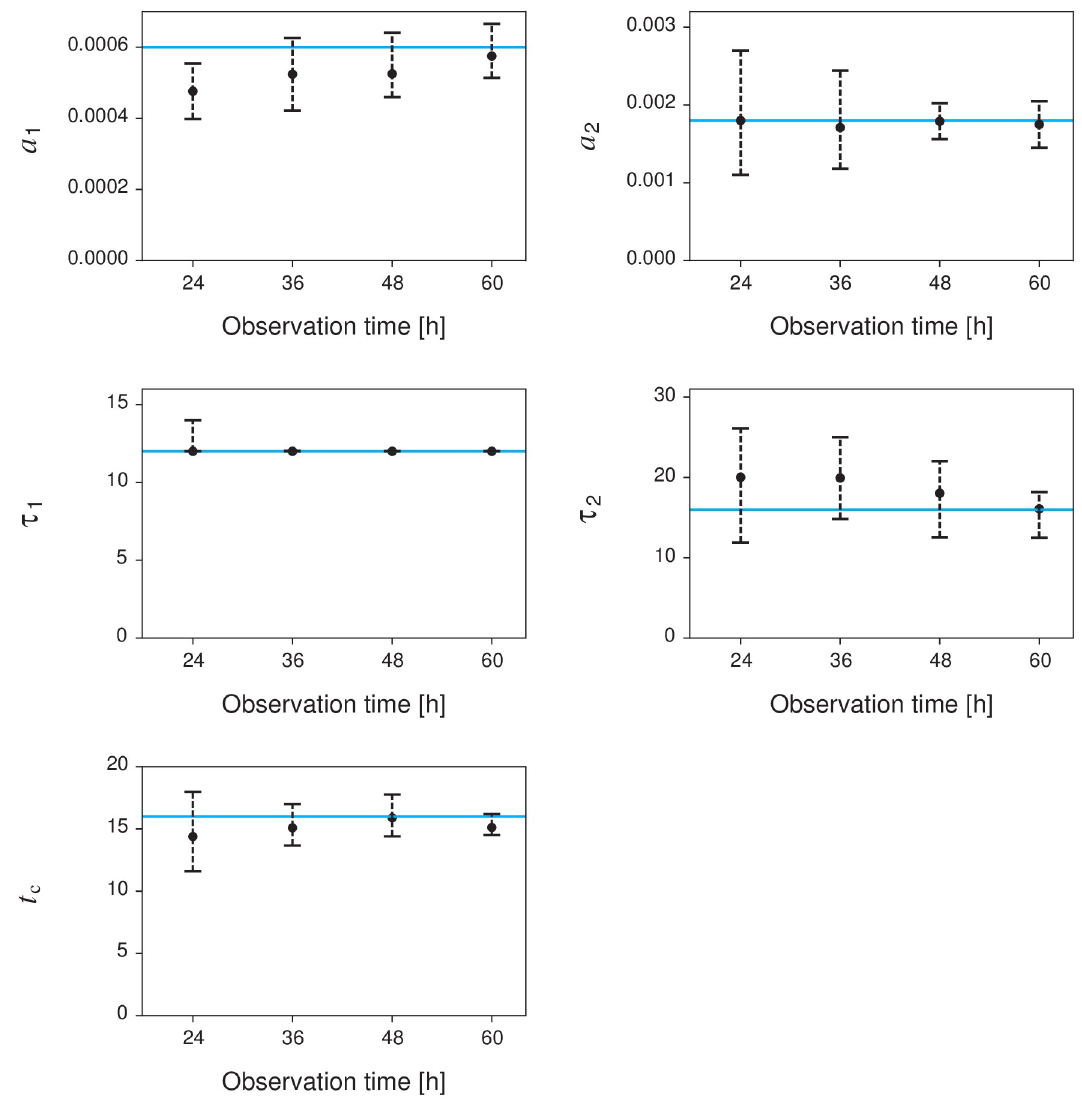
Fig 2. Dependence of the estimation accuracy of parameters { a 1 , τ 1 ; a 2 , τ 2 ; t represent the median and interquartile ranges of the estimates obtained from 100 synthetic data. Cyan lines indicate the true value: a 1 = 0.0006, a 2 = 0.0018, τ 1 = 12, τ 2 = 16, and t c =